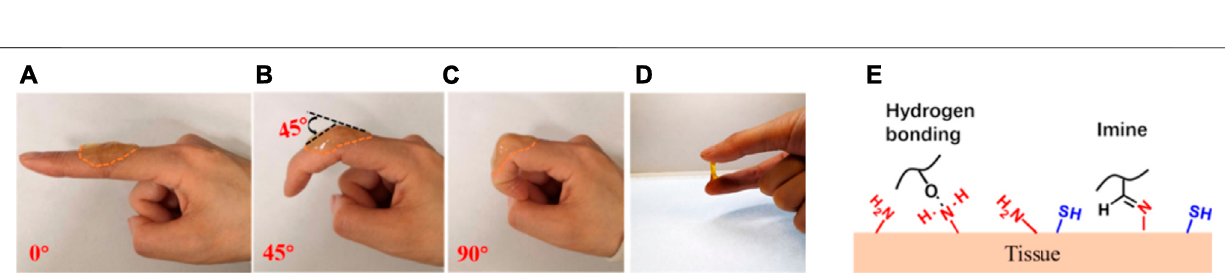
Frontiers in Bioengineering and Biotechnology |